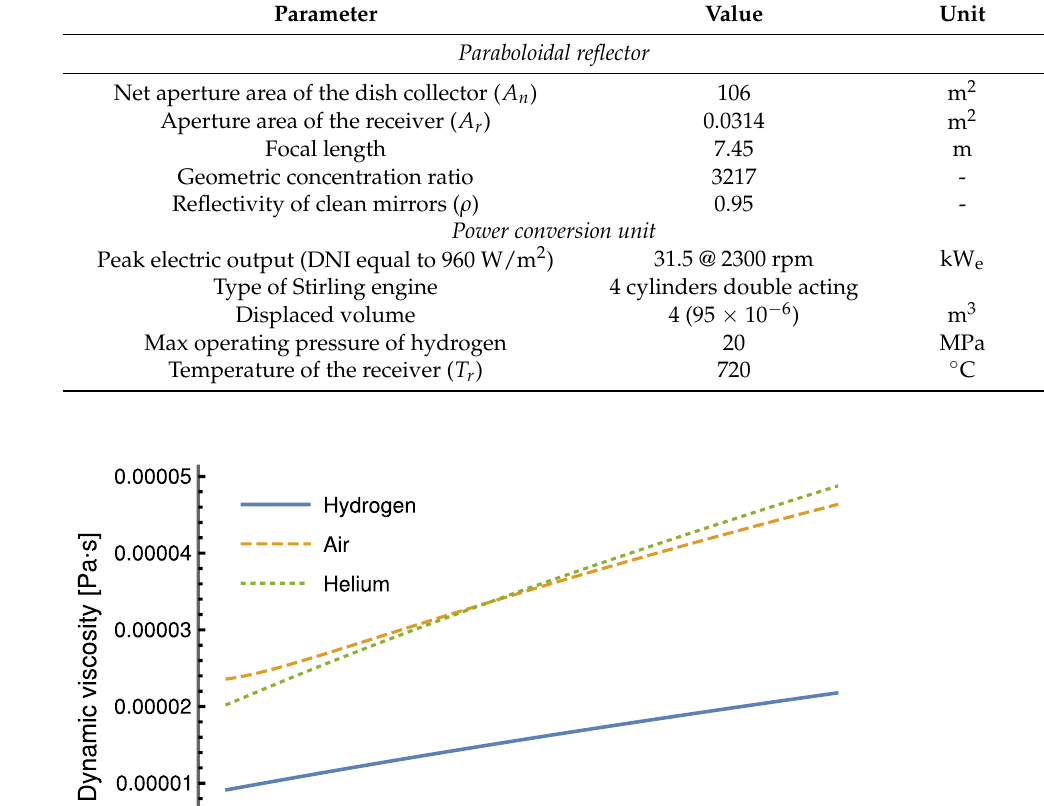
Table 1. Main technical parameters of the dish–Stirling system. Parameter Value Unit Paraboloidal reflector